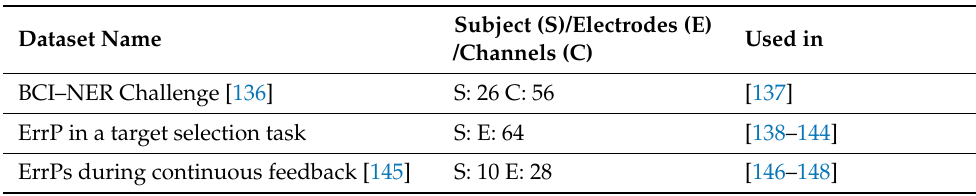
Table 3. A table of different types of Error-Related Potentials (ErrP) dataset of BCI.